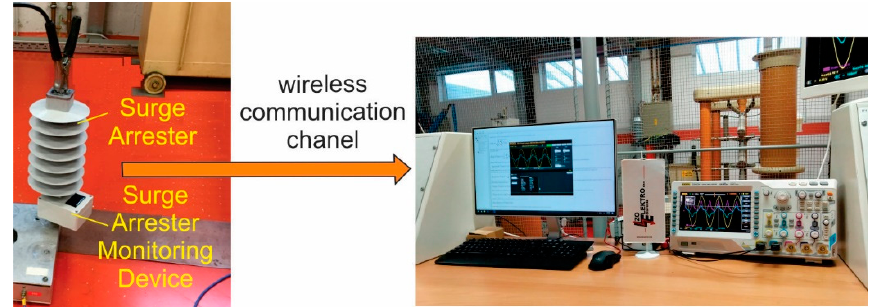
Figure 11. Measurement set-bench.